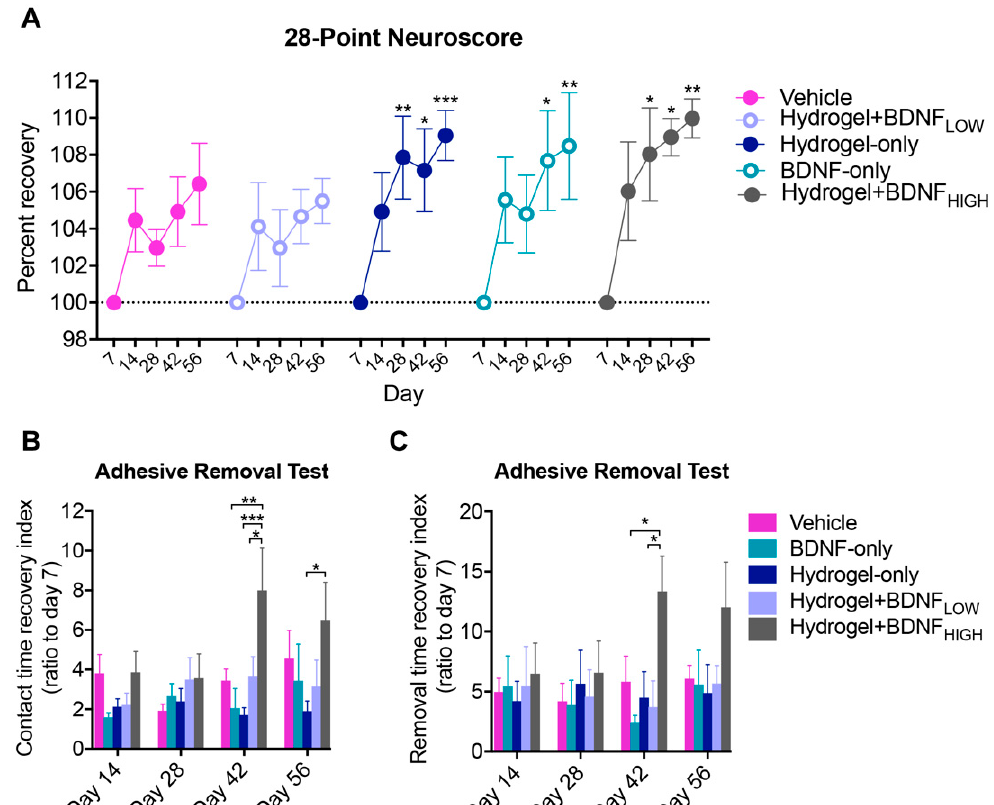
Figure 2. Effects of BDNF and delivery vehicle on sensorimotor function following dMCAo. ( A ) Sensorimotor deficits, measured using the 28-point Neuroscore (28-PN), improve following treatment with hydrogel-only, BDNF-only, or hydrogel + BDNF HIGH . Improvement measured as percent recovery compared to day seven. ( B ) Performance on the adhesive removal test (ART) contralateral to injury. Contact time recovery index significantly improved in the hydrogel + BDNF HIGH group on days 42 and 56. ( C ) Removal time recovery index significantly improved in the hydrogel + BDNF HIGH group on day 42. Vehicle ( n = 4), BDNF-only ( n = 7–9), hydrogel-only ( n = 7–9), hydrogel + BDNF LOW ( n = 7–9), and hydrogel + BDNF HIGH ( n = 6–11). Error bars indicate the mean ± SEM; * p < 0.05, ** p < 0.01, *** p <